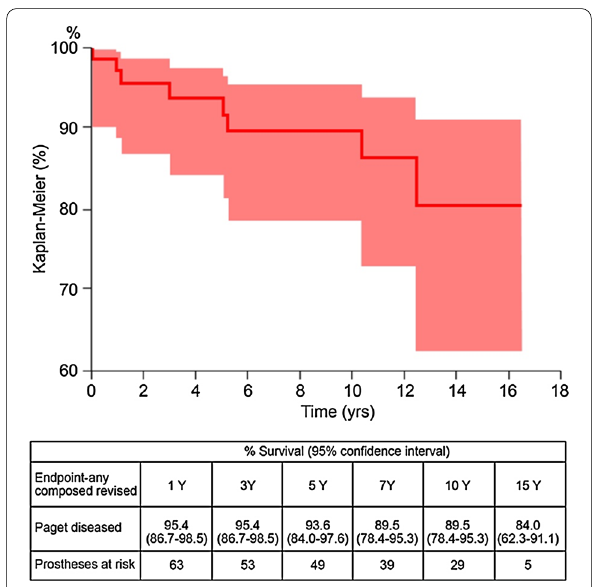
Fig. 1 Survival of THA implants in Paget’s patients